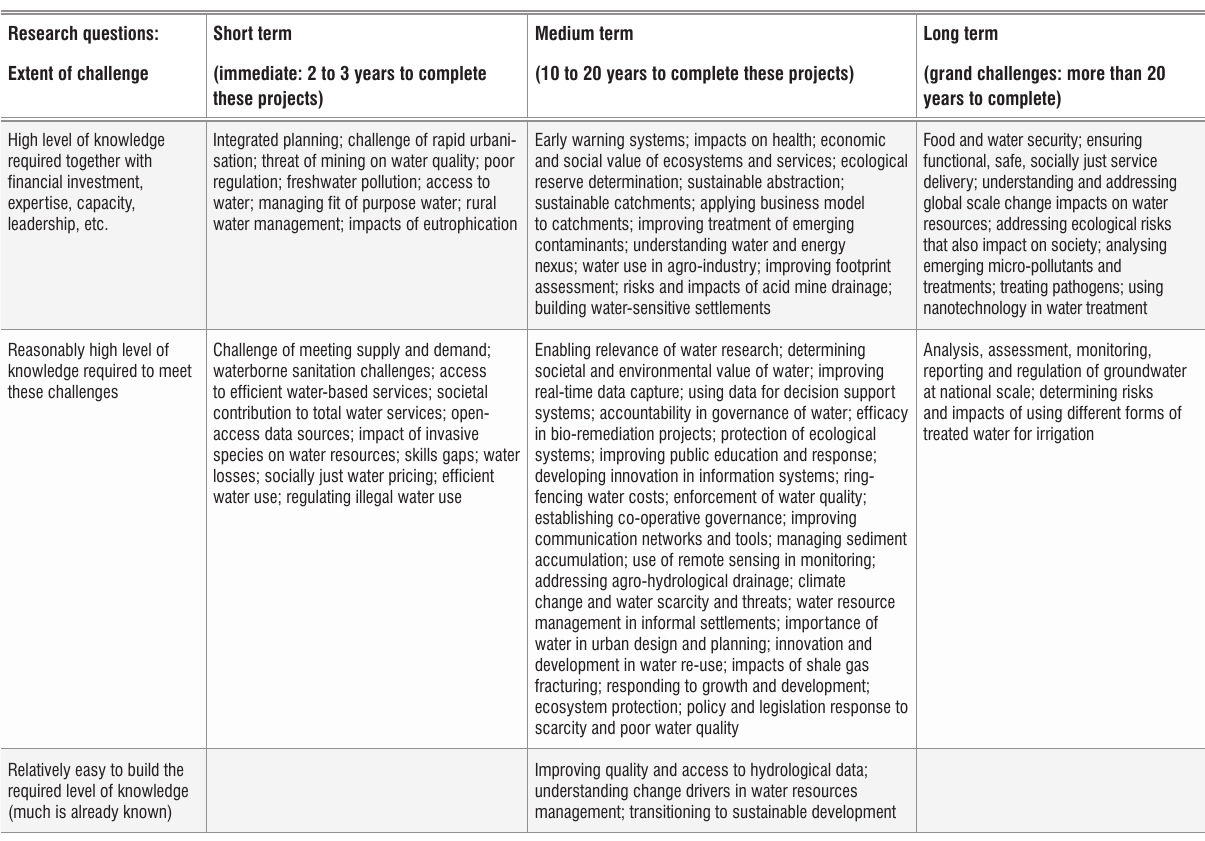
Categorisation and organisation of the research question data